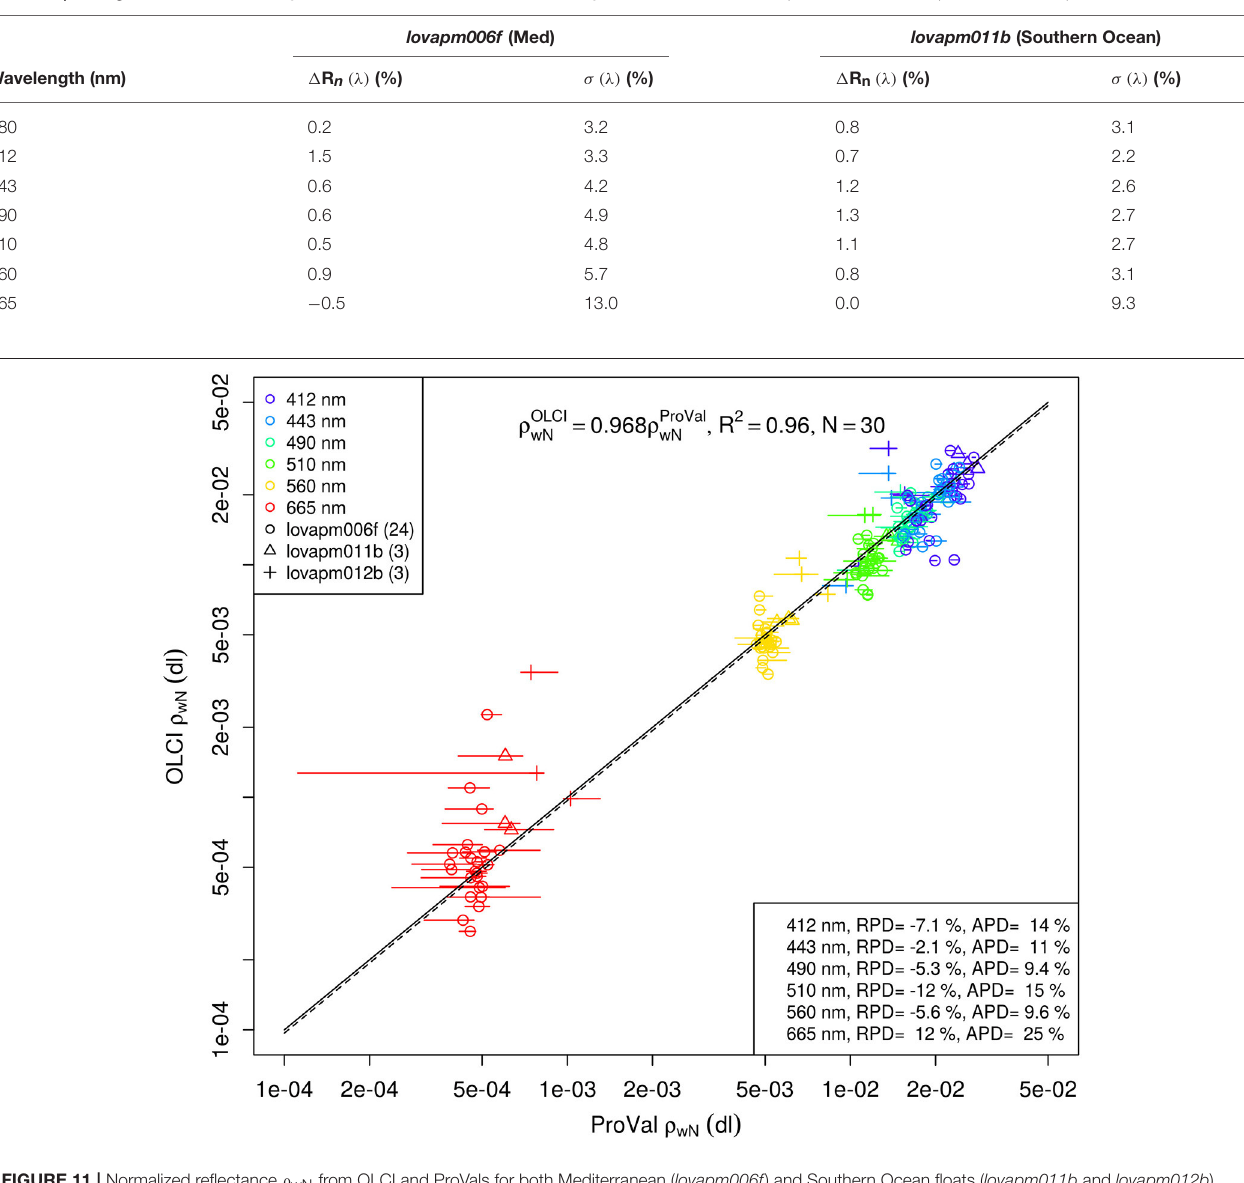
FIGURE 11 | Normalized reflectance ρ wN from OLCI and ProVals for both Mediterranean ( lovapm006f ) and Southern Ocean floats ( lovapm011b and lovapm012b ). Error bars on the ProVal data are given by the minimum and maximum of the four normalized reflectance values. The solid line represents the 1:1 line while the dashed line is the linear regression. The number of match-ups for each float are given in brackets in the top-left